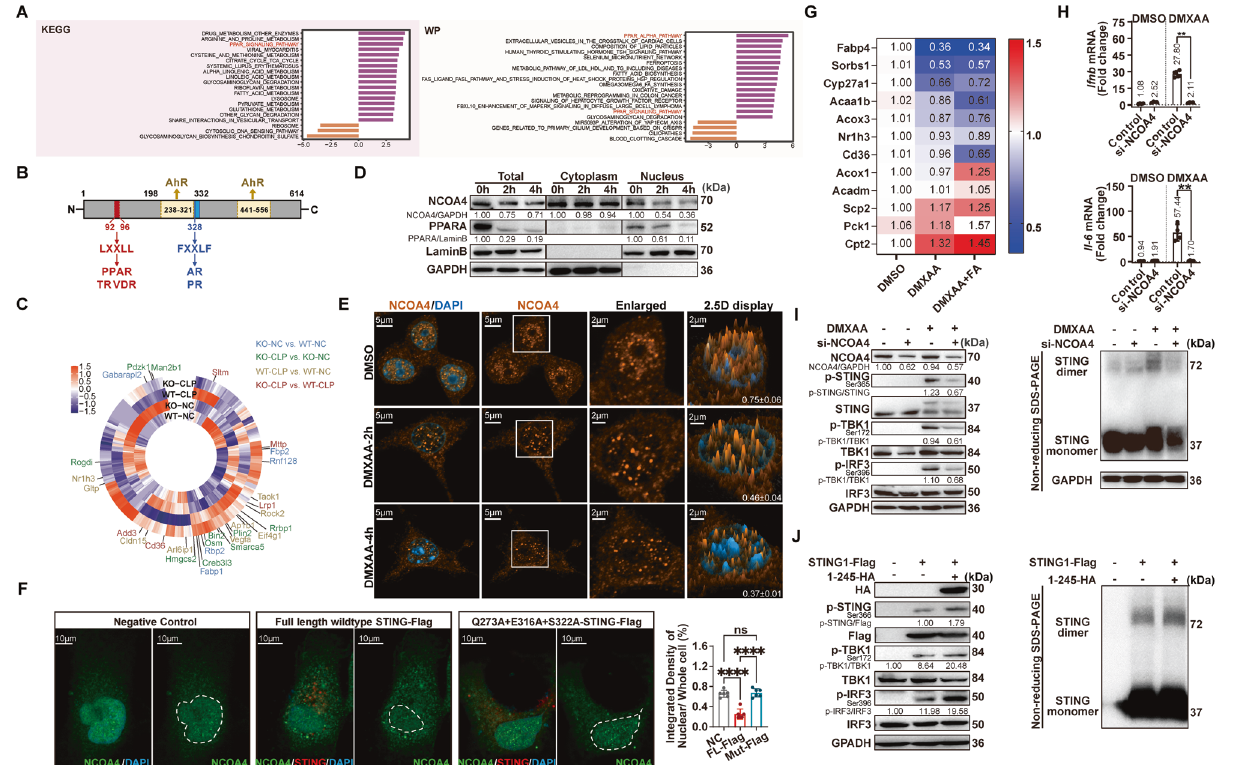
Fig. 5 NCOA4 binds with STING to maintain STING activation that promotes ferritinophagy and lessens nuclear localization. A Differential pathways enriched in WT and Sting1 − / − mice after CLP model by GSVA. P values were calculated by two-sided moderated t -tests using limma. B Schematic representation of human NCOA4. The full-length NCOA4 is known as NCOA4 α . The LXXLL motif located at amino acids 92 – 96 and the FXXLF motif located at amino acids 328 – 332, which is involved in interaction with PPAR, thyroid hormone (TR), vitamin D receptor (VDR), androgen receptor (AR), and progesterone receptor (PR), respectively. Amino acids 231 – 321 and 441 – 556 are domains for aryl hydrocarbon receptor (AhR) coactivation. C Circos plot illustrates the relative expression level of peroxisome proliferator-activated (PPAR) downstream target genes in macrophages in WT and Sting1 − / − mice subjected with and without CLP model. Differently expressed genes (DEGs) between indicated groups were highlighted in different colors. D Immunoblot analysis of the indicated proteins in RAW264.7 cells treated with 50 μ g/ mL DMXAA for 2 and 4 h. E The fl uorescence distribution of NCOA4 in nucleus and cytosol after stimulated with 50 μ g/mL DMXAA for 2 and 4 h ( n = 3 per group). The peak value of the z -axis in the 2.5D display column represents the fl uorescence intensity. The quanti fi ed nuclear localization proportion of Ncoa4 is shown in the lower right corner. F Hela cells were transfected with the indicated STING1 plasmids (1.5 μ g) alone for 24 h. The quantitative analysis of nuclear localization of NCOA4 is shown in the rightmost panel; Green fl uorescence, NCOA4; Red fl uorescence, STING1 -Flag; Blue fl uorescence, DAPI; White dashed line indicated the nuclei borders. G Heatmap of selected PPAR α target genes expression analysis by qPCR of the RAW264.7 cells after DMXAA (75 μ g/mL) stimulation in combination with Feno fi bric acid (FA, 100 μ M) or vehicle (DMSO) for 16 h ( n = 3 per group). H qPCR analysis of Il-6 and Ifnb mRNA in RAW264.7 cells transfected with siNCOA4 (50 nM) and treated with 75 μ g/mL DMXAA for 16 h ( n = 4 per group). I Immunoblot analysis of STING pathway in RAW264.7 cells transfected with